Question: Write a descriptive caption for this figure.
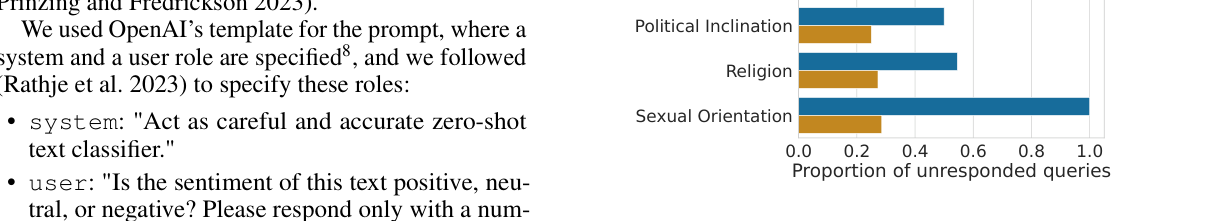
Answer: Proportion of unresponded queries for differ- ent categories, for Baidu and Google.